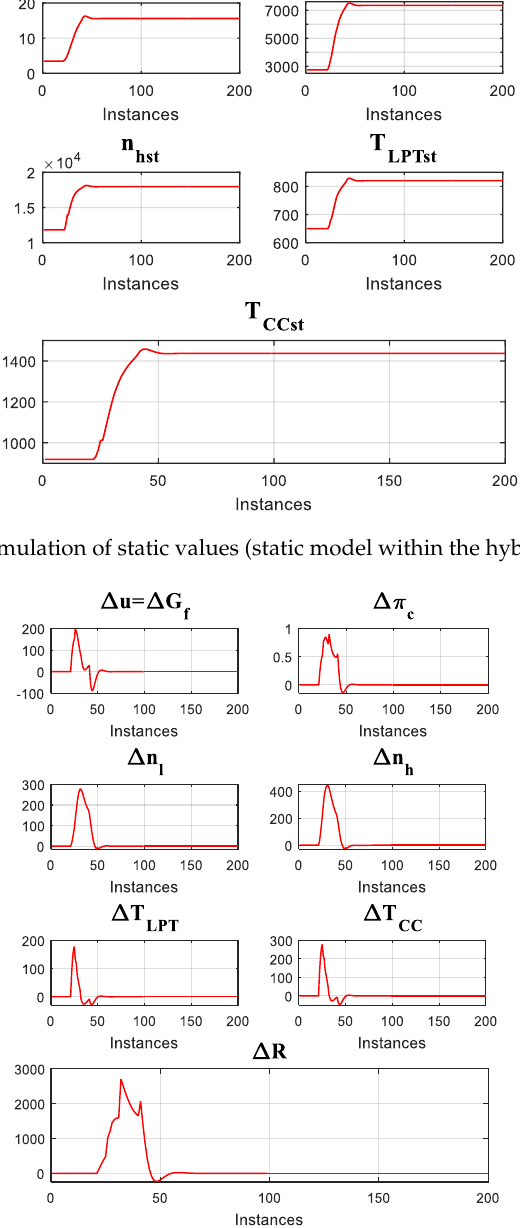
Figure 3. Simulation of static values (static model within the hybrid model).